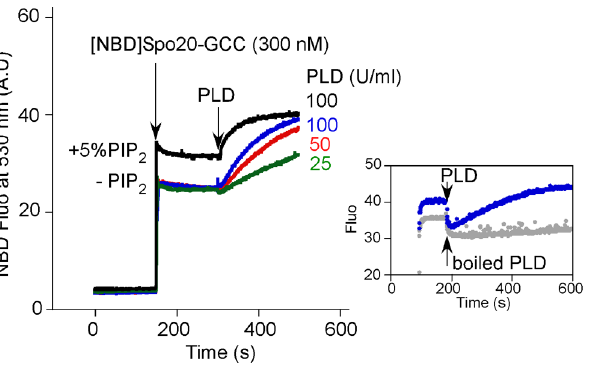
Figure 5. Real-time measurement of PA production by an extract containing PLD activity. The fluorescence cuvette contained liposomes (0.35 mM lipids; extrusion 0.2 m m) with 25 mol % PE, 25 mol % cholesterol supplemented or not with 5 mol % PIP 2 . The remaining lipid was PC. Then, [NBD]Spo20-GCC (0.3 m M) and a PLD extract from Streptomyces chromofuscus (25 to 100 U/ml) were sequentially added. Experiments were carried out in triplicates; representative traces are shown. Inset: comparison between PLD and boiled PLD under the same conditions.